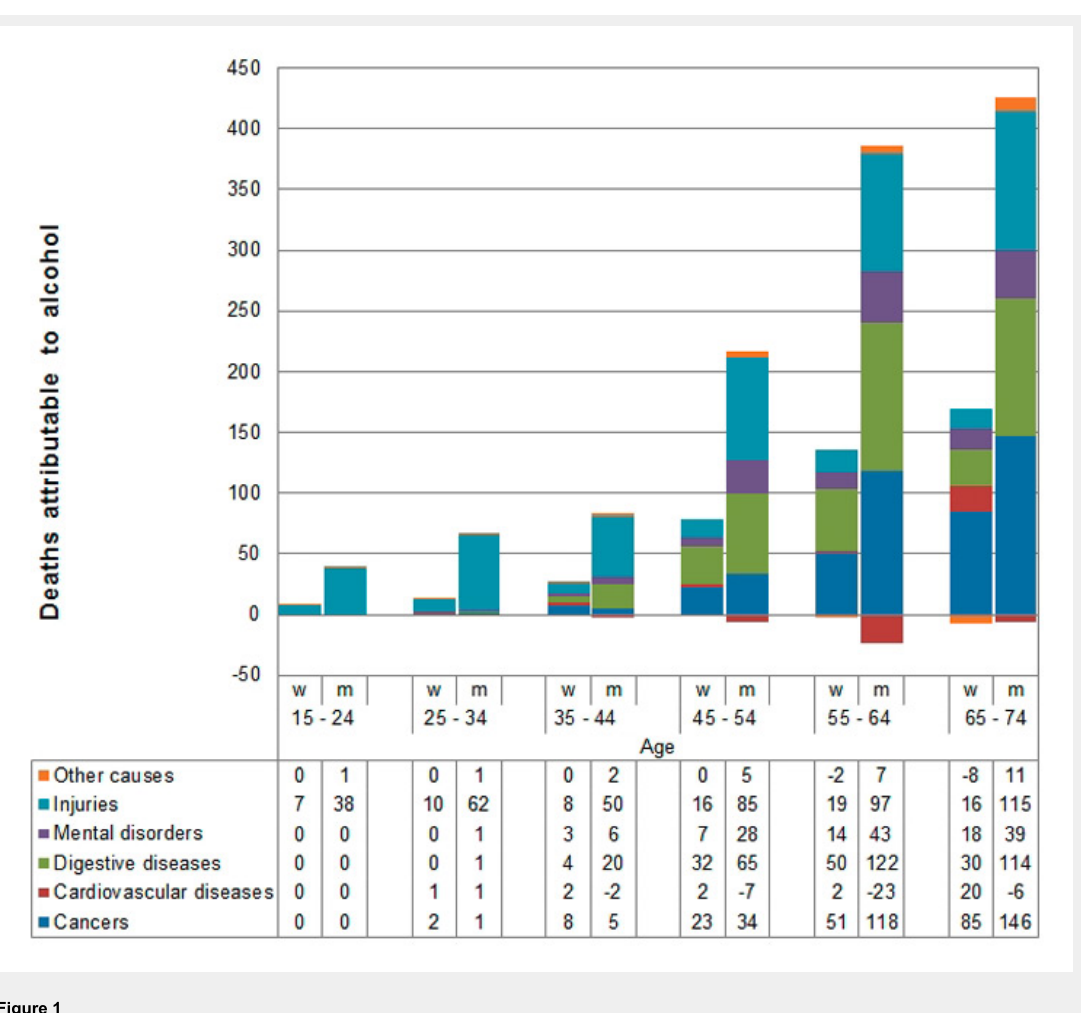
Alcohol-attributable deaths by age and sex and broad categories. For definition of categories see supplementary table